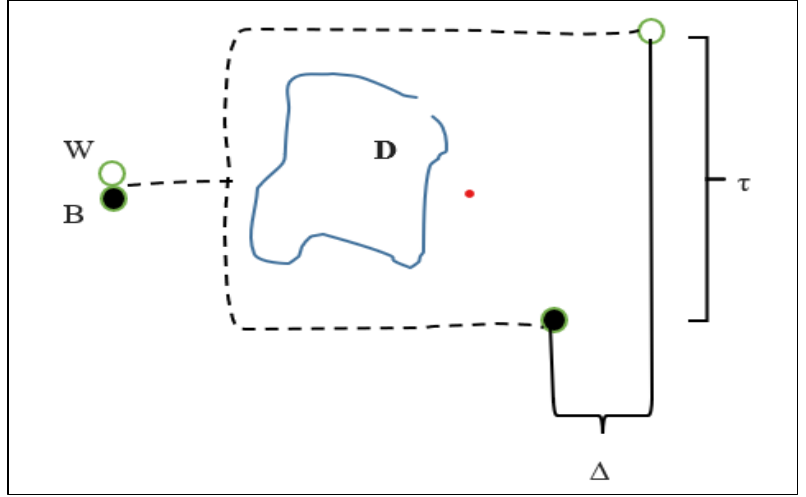
Figure 1: Random separation of a couple of